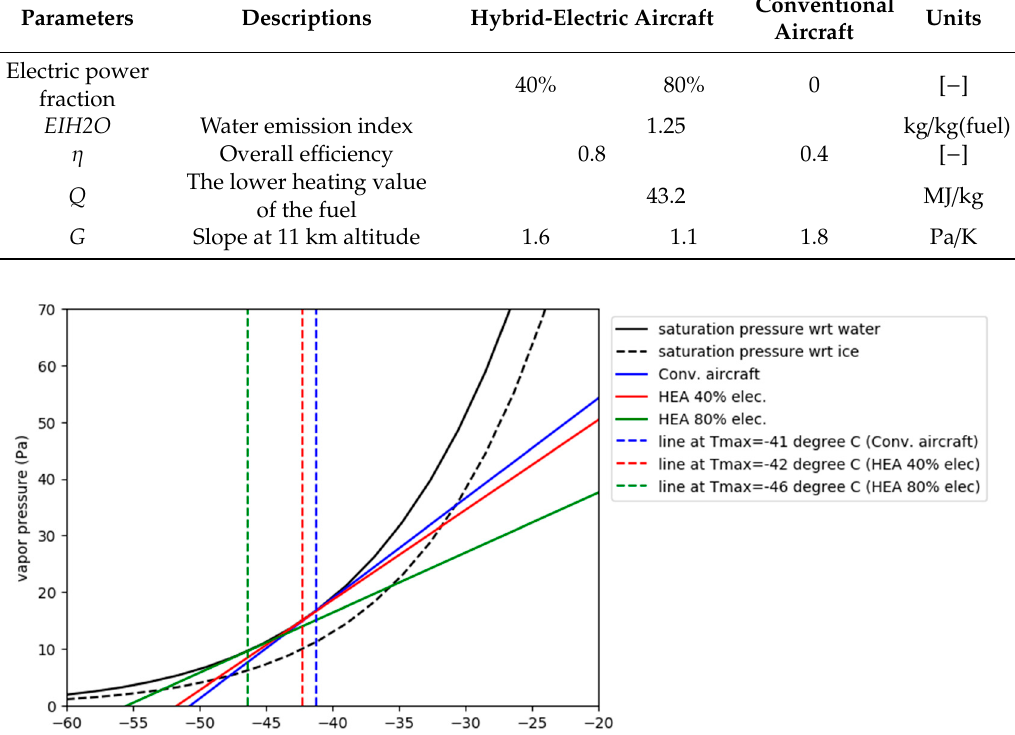
Figure 7. Mixing line for threshold conditions. Water vapor pressure vs. temperature phase diagram representing thermodynamics of contrail formation for a conventional aircraft with overall propulsion efficiency of 0.4 (blue line) and HEA with two different degrees of hybridization: 40% electric power (red line) and 80% electric power (green line). The two black curves are the saturation vapor pressure curves for water (solid) and with respect to ice (dashed). The vertical dashed lines represent the temperature threshold for the conventional aircraft (blue), HEA with 40% electric power (red), and HEA with 80% electric power (green).